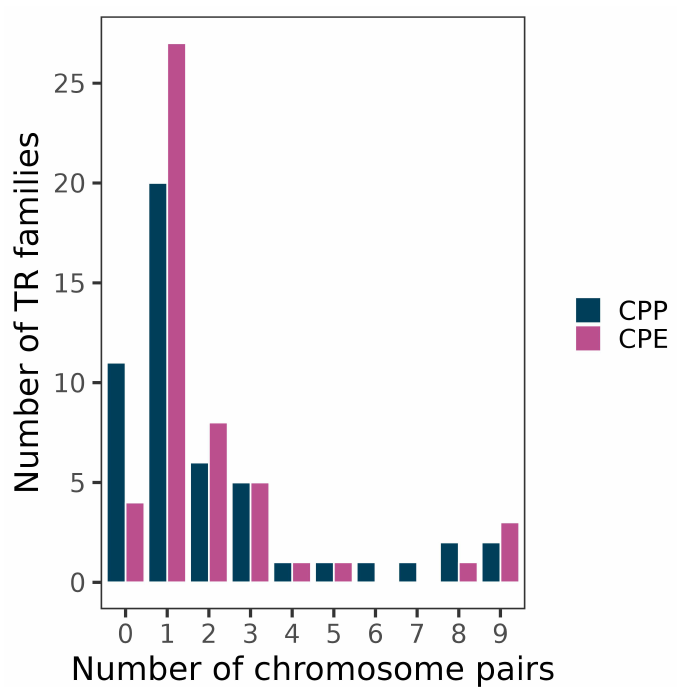
Figure 2. Spread of TR families among non-homologous chromosome pairs. Note the predominance of families being located on only one chromosome pair (20 in CPP and 27 in CPE).